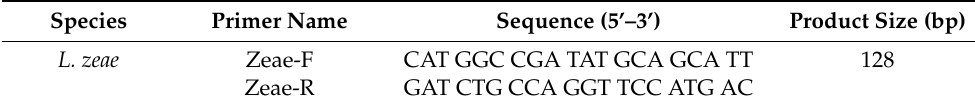
Table 3. Primer information for L. zeae designed in this study.